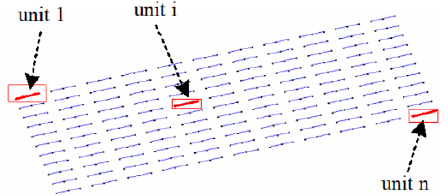
Figure 2. Illustration of a dipole array antenna.